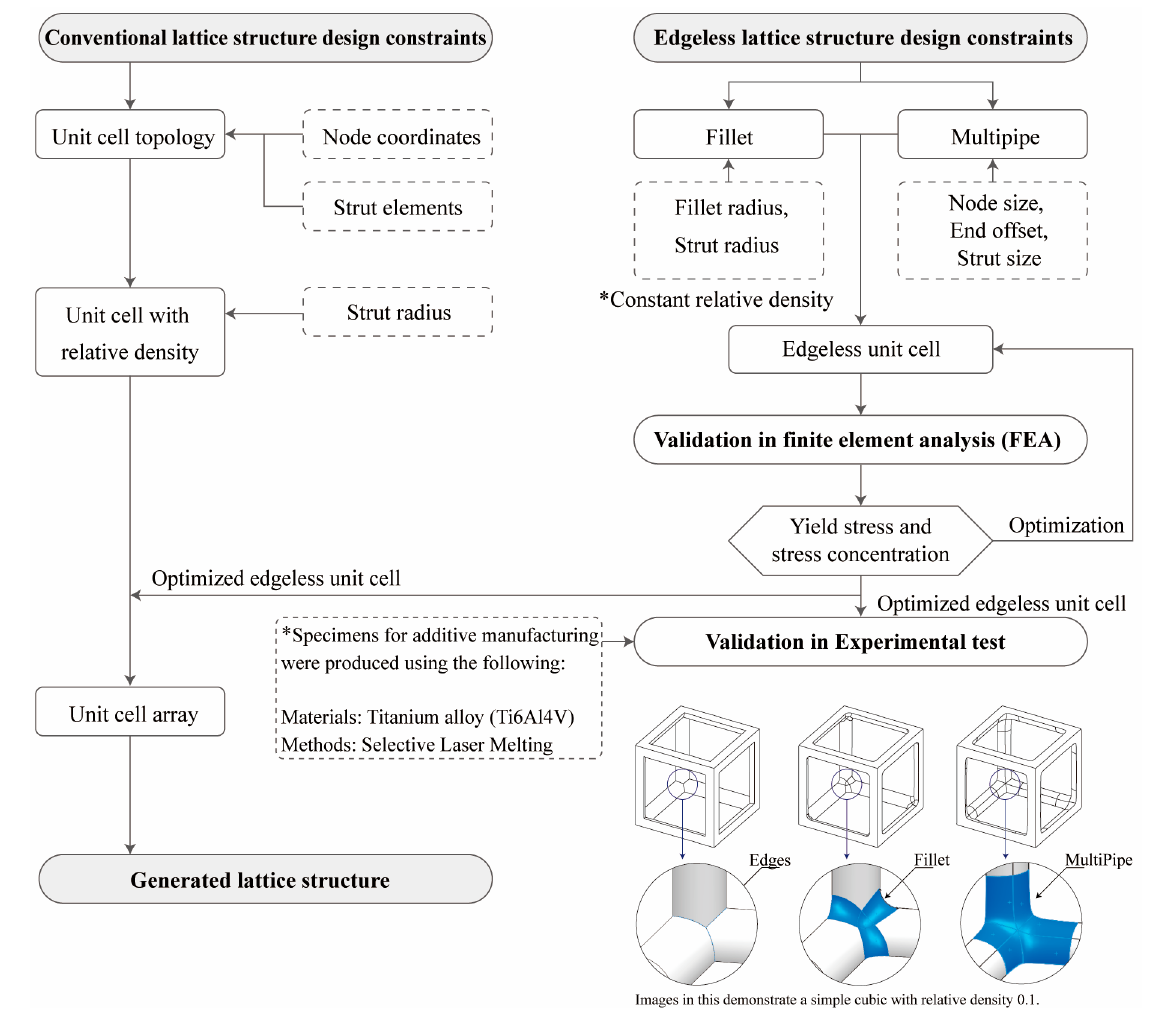
Figure 1. Optimization method of the edgeless la tt ice structure con fi guration and the scheme of the study.